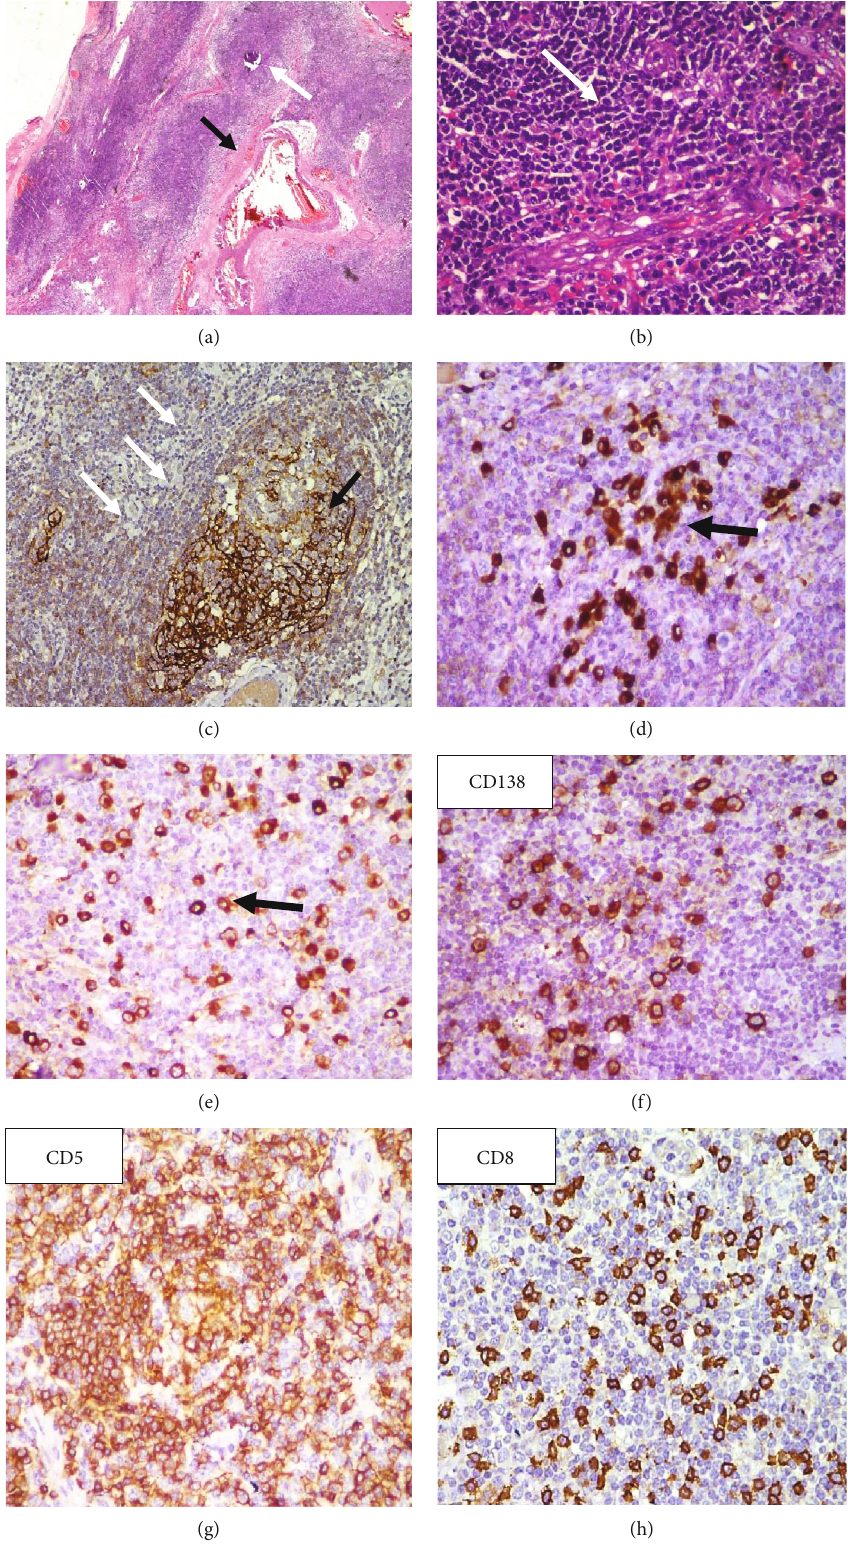
Figure 4: Histopathology suggestive of extranodal CD revealed (a) extranodal tissue showing a dilated blood vessel (black arrow) with multiple sheaths of lymphoid cells with attempted ill-formed follicles (white arrow) (HES2X), (b) mature looking lymphocytes (white arrow) (HES40X), (c) follicular dendritic cells positive for CD23 (black arrow) with garlanding ( “ onion skinning ” ) of lymphocytes around it (white arrow), (d) polyclonal expression of kappa and (e) lambda, and (f) CD138-positive for plasma cells (g) CD5-positive T cells and (h) cytotoxic CD8